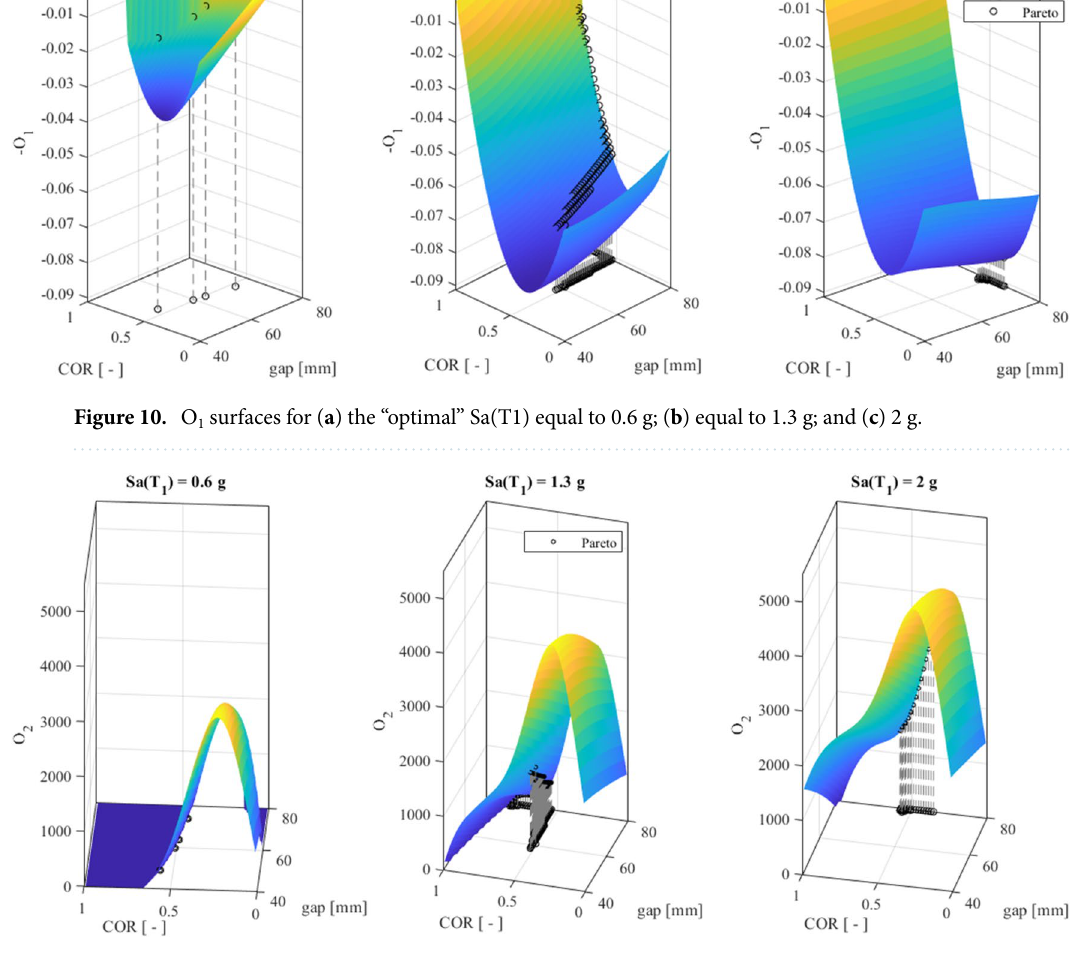
Figure 11. O 2 surfaces for ( a ) the optimal Sa(T1) equal to 0.6 g, ( b ) 1.3 g, and ( c ) 2 g.